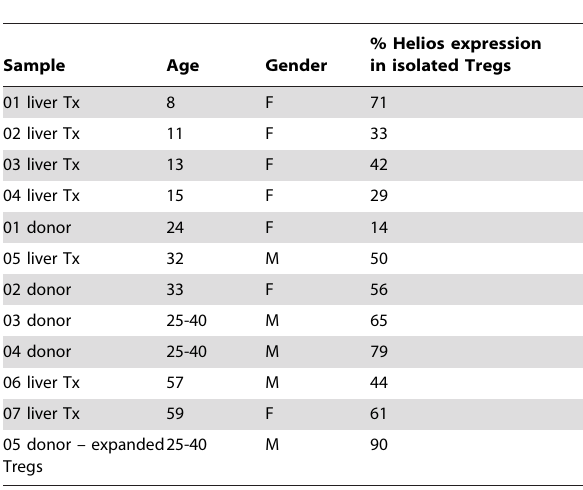
Table 2. Helios expression in Tregs in different ages.